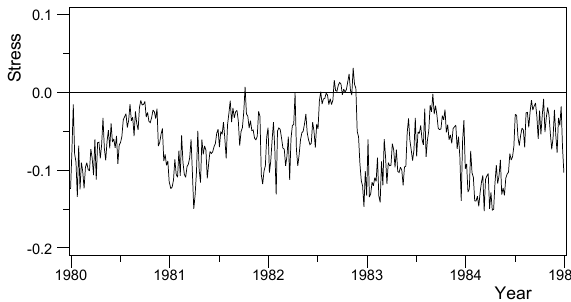
Figure 10. Eastward component of wind stress (Pa) at 180 ◦ E, 6 ◦